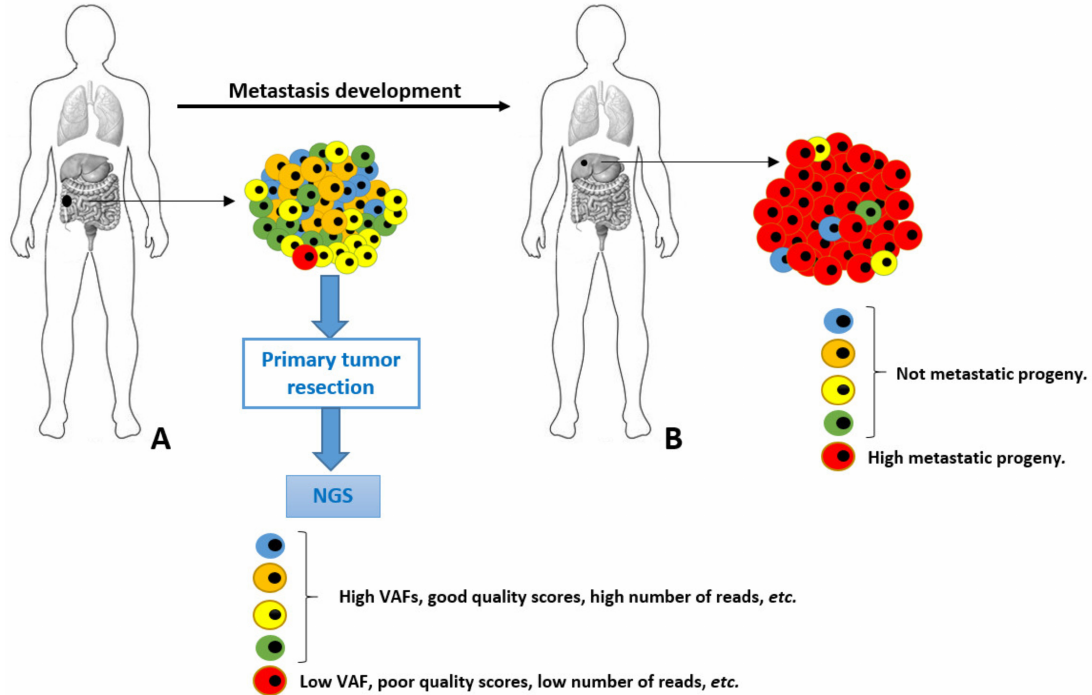
Figure 1. Schematic representation of tumor cells heterogeneity and evolution from primary ( A ) to metastatic lesion ( B ). The highly metastatic red cell in primary tumor is analytically underestimated in NGS performed in A